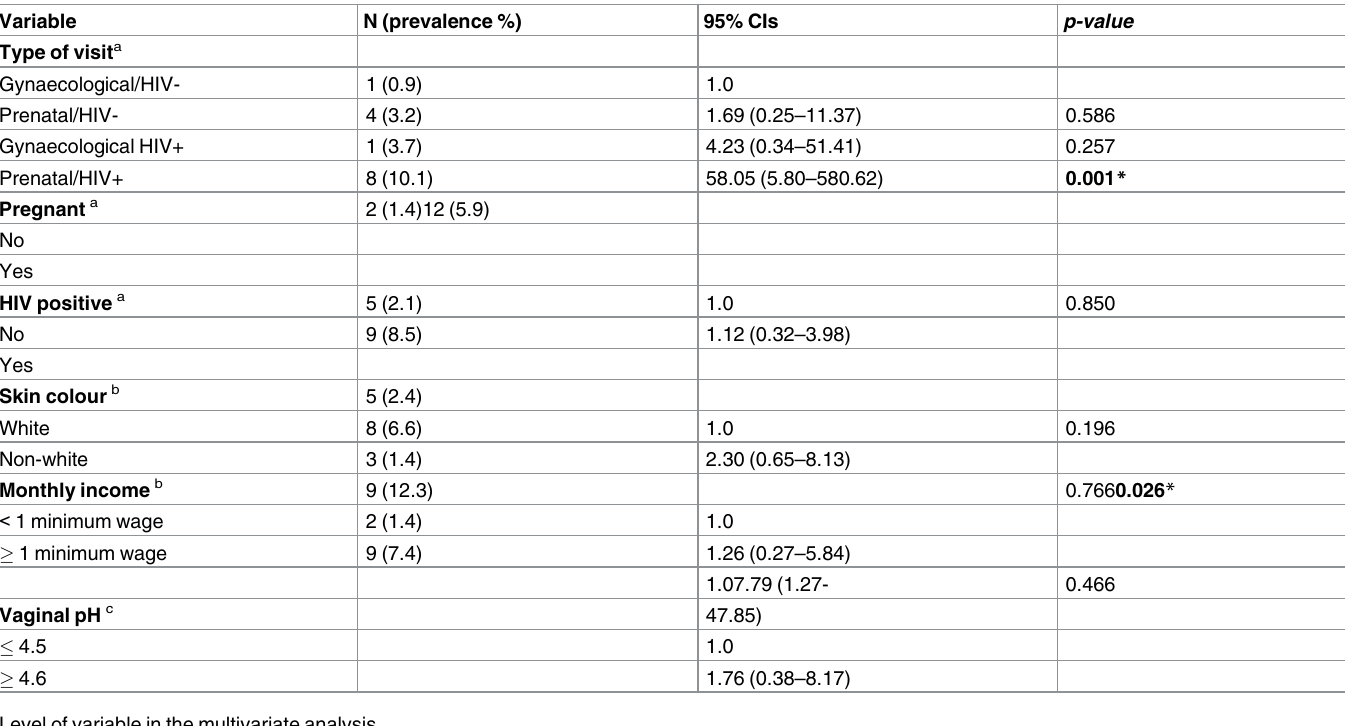
Table 5. Multivariate analysis of the diagnosis of trichomoniasis in women treated at the University Hospital of Rio Grande, Rio Grande do Sul, Brazil. Trichomoniasis was diagnosed using polymerase chain reaction (PCR) with the TVK3/7 primer set. Period betweenJanuary2012 and January 2015 (n =